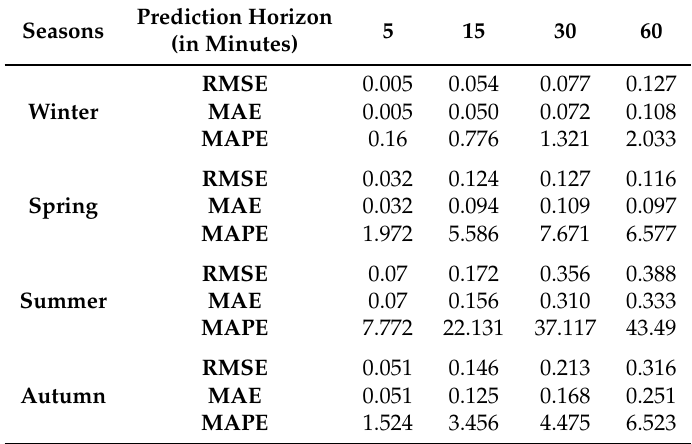
Figure 5. Power curves for datasets from ( a ) winter, ( b ) summer, ( c ) spring, and ( d ) autumn. Table 4. Performance of proposed methodology for wind power